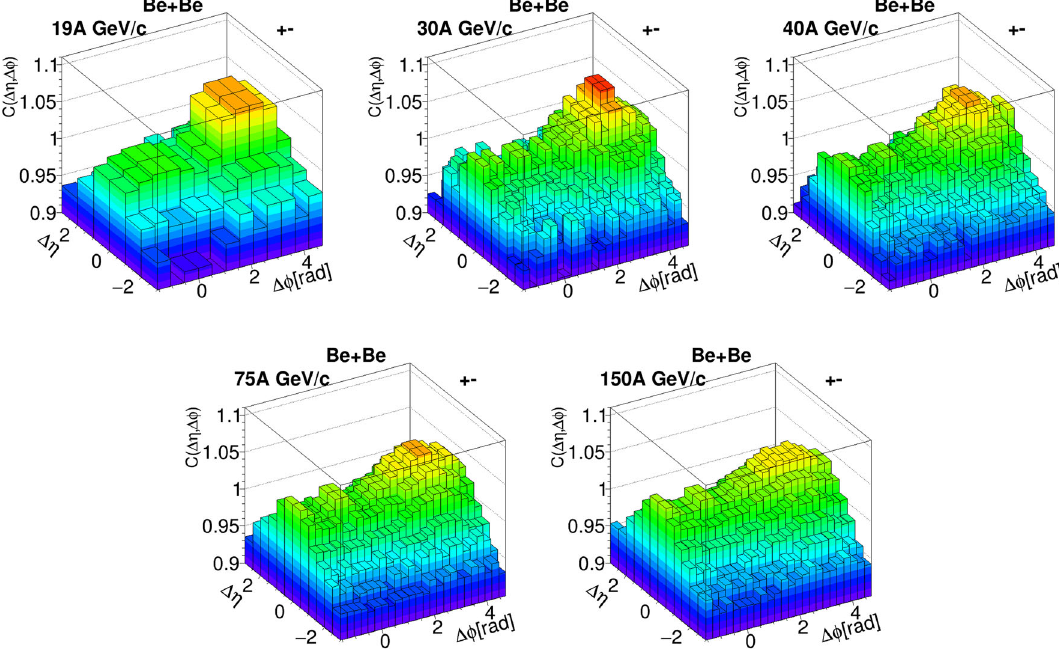
Fig. 7 Two-particle correlation function C ((cid:2)η,(cid:2)φ) for unlike-sign pairs in the 5% most central Be + Be collisions at 19 A –150 A GeV /